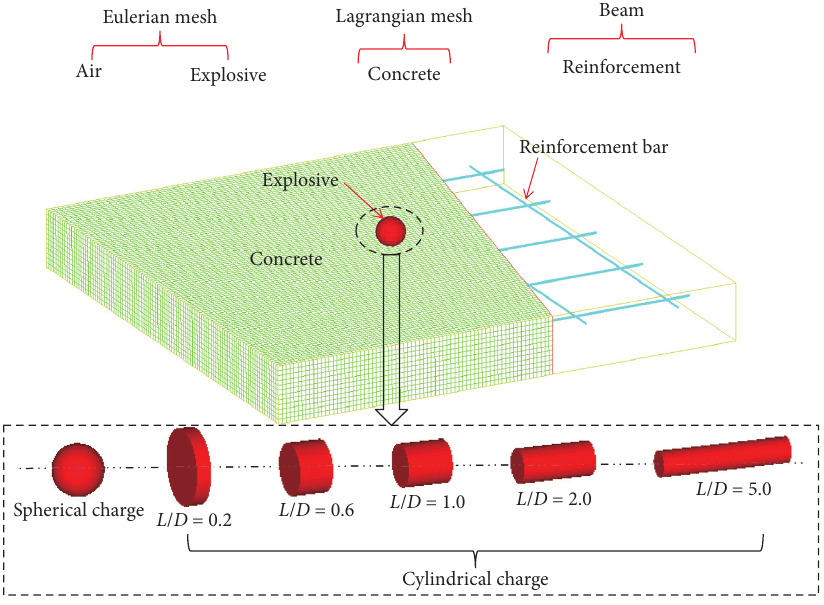
Figure 15: Finite element numerical model of the RC slab under contact